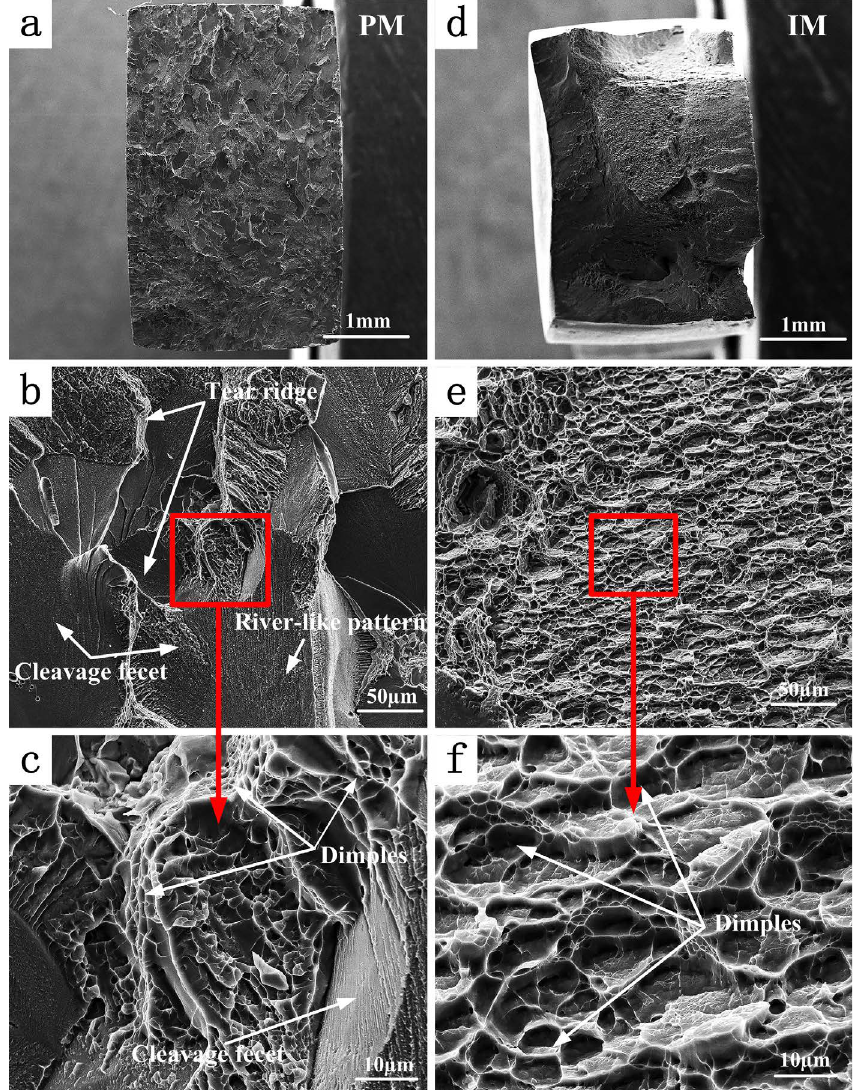
Figure 2. SEM images of macroscopical and microscopical fracture surface morphologies of the specimens after tensile tests of as-consolidated PM and as-cast IM Ti-5553 alloys: (a) PM macroscopical scale; (b) and (c) PM microscopical scale; (d) IM macroscopical scale; (e) and (f) IM microscopical